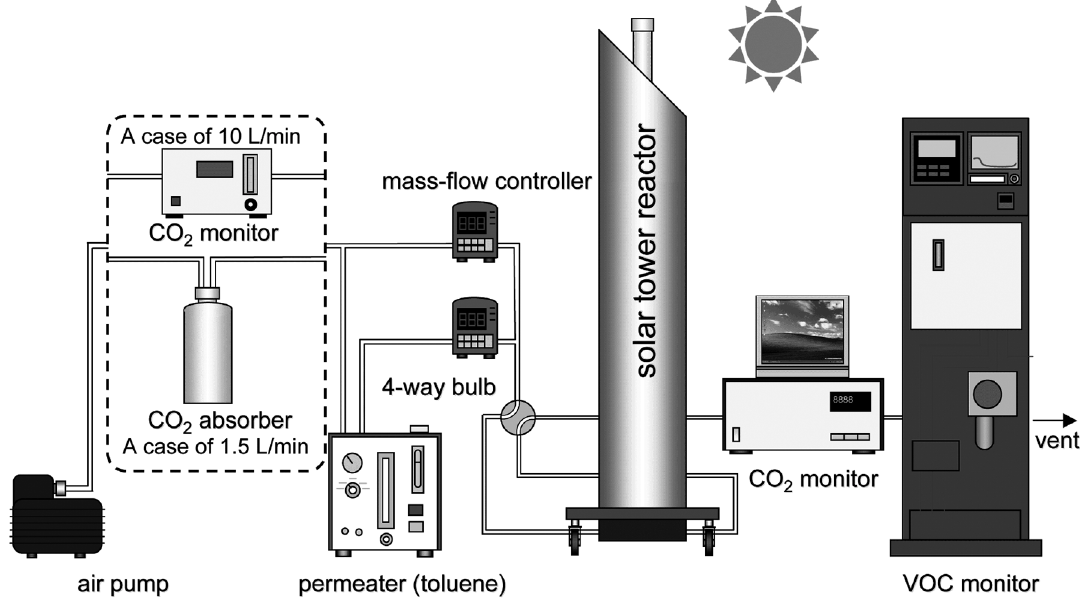
Figure 12. Scheme of the gas flow system for the evaluation of the performance of the solar tower